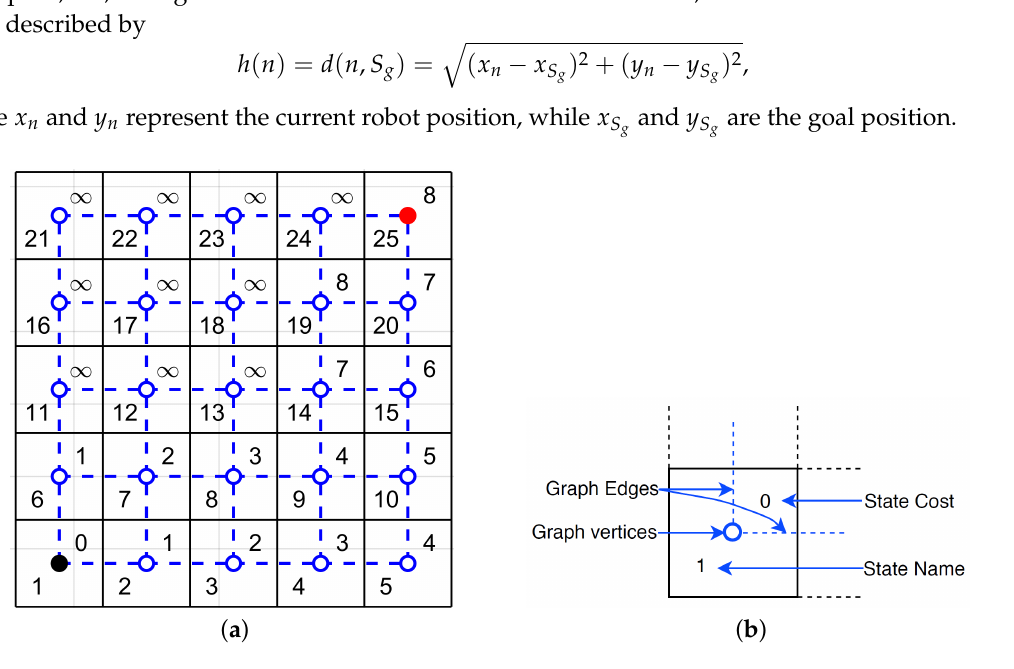
Figure 2. ( a ) Map and graph used in the experiment and ( b ) its characteristics. It is noteworthy that when the state cost is ∞ , the node or state is not